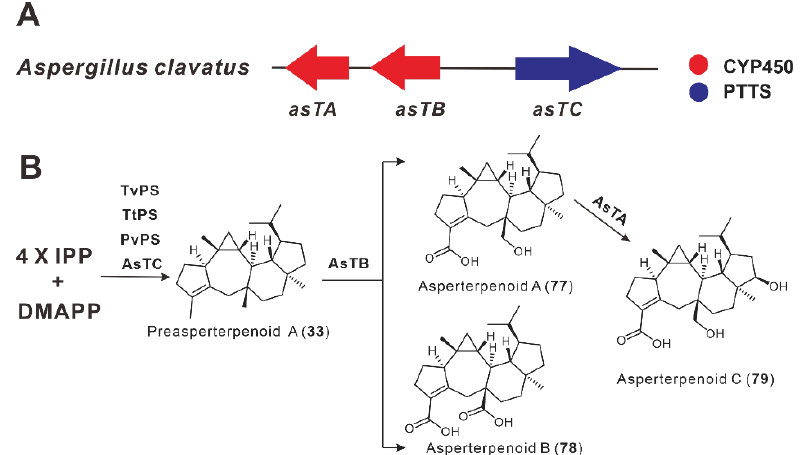
Figure 8. The BGC for asperterpenoids ( A ) and its biosynthetic pathway ( B ). Gao et al. discovered two silent BGCs involved in the biosynthesis of betaestacin I ( 24 ) in two plant pathogenic fungi, P. betae and C. orbulare , in 2018. Both BGCs contain a PTTS (BtcA Pb /BtcA Co ) and two CYP450 oxidases (Figure 9A), and the heterologous expression of btcA Pb or btcA Co results in the production of betaestacin I ( 24 ). There are two pairs of homologous CYP450s in these two BGCs. The first pair of CYP450s, BtcB Pb and BtcB Co , catalyzed multiple oxidations of 24 with varying degrees of oxidation. The compound 24 is further oxidized by btcB Pb to betaestacin II ( 80 ) in the Btc BGC pathway from P. betae , whereas 24 is oxidized by btcB Co to betaestacin III ( 81 ), and further oxidized to IV ( 82 ) in the btc Co pathway. The modifications of the second pair of homologous CYP450s, BtcC Pb and BtcC Co , were different. BtcC Pb was unable to oxidize 80 further, whereas btcC Co catalyzed the multistep oxidation of 82 , yielding four new sesterterpenoids, betaestacinVa-c ( 83 – 85 ) and VI ( 86 ) (Figure 9B) [35].